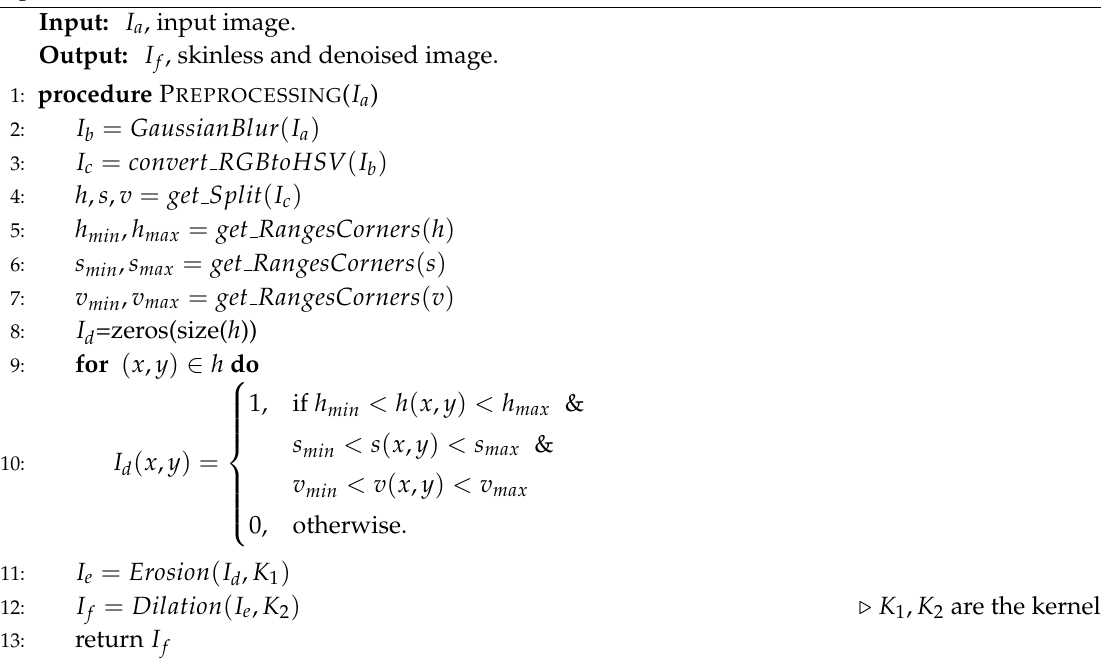
Algorithm 2 Proposed method for skin removal, showing lines 1–13, corresponding to the images in Figure